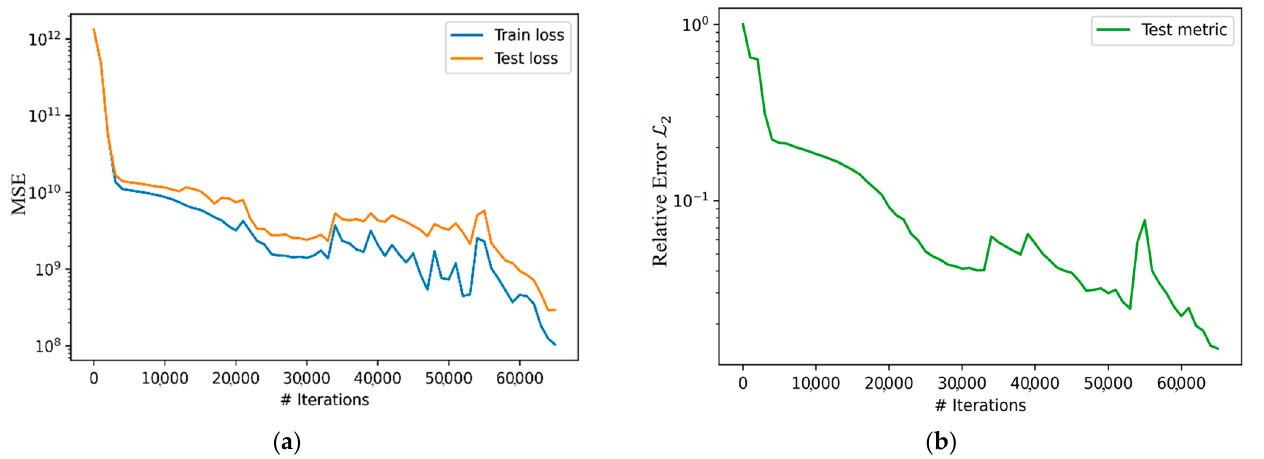
Figure 9. History of the loss function of PINN after 65,000 iterations for extrapolation. ( a ) The training (blue) and testing (orange) loss is the summed-up MSE loss of all terms in the PKEs. ( b ) The test metric is the relative L 2 error for the first ODE